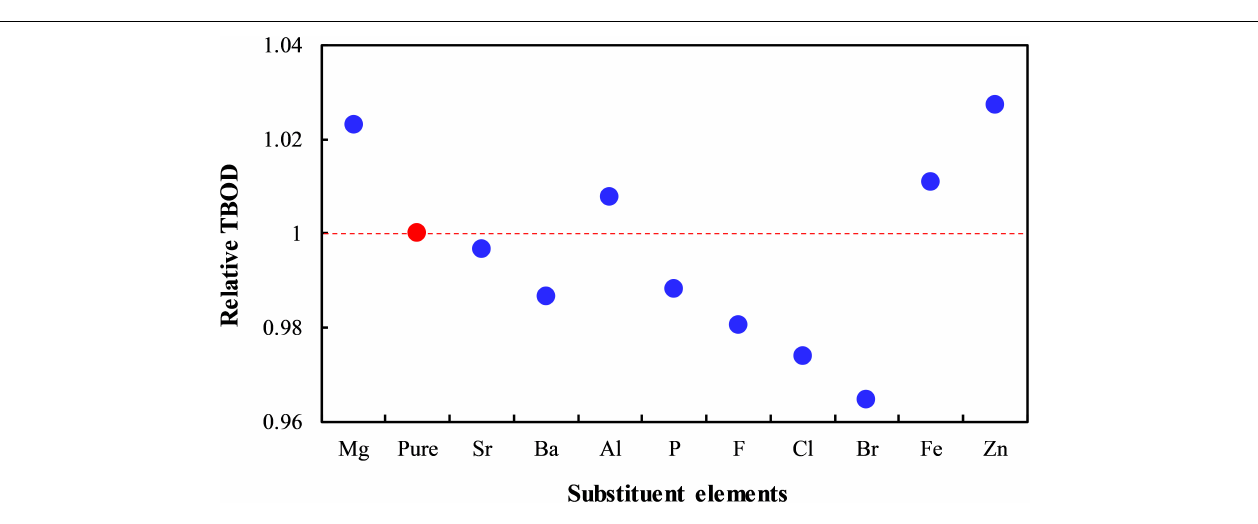
Frontiers in Materials |